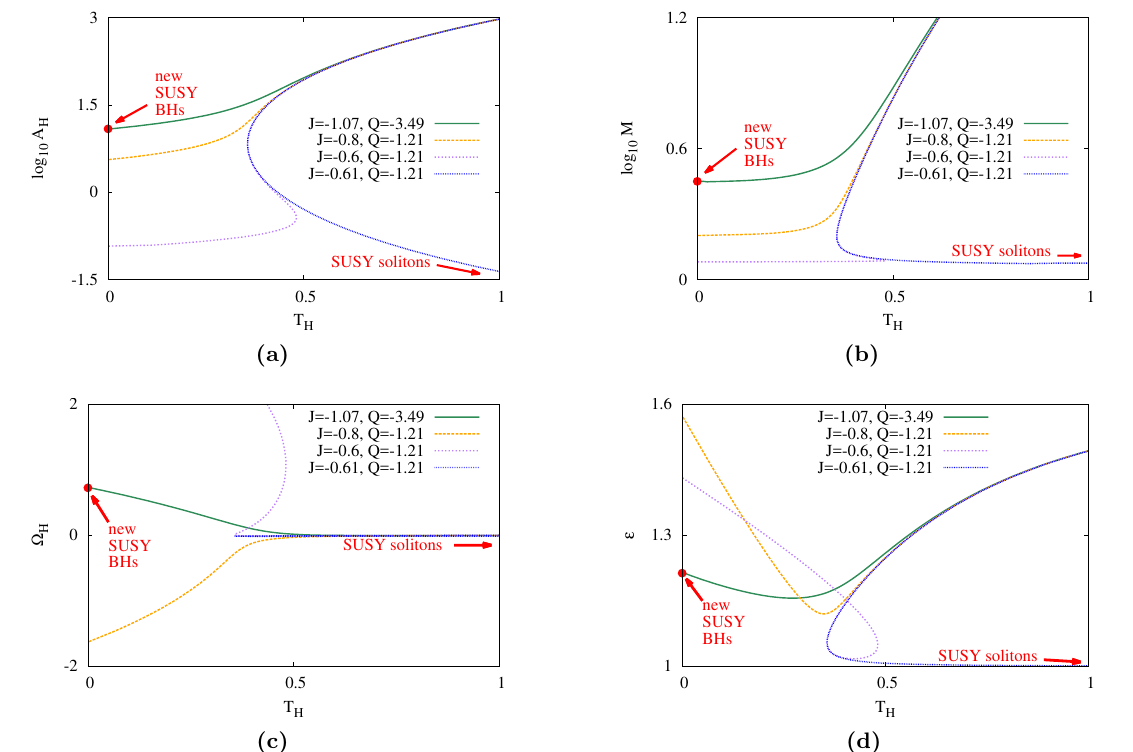
Figure 4. Several properties of squashed magnetized black holes are shown as a function of the horizon temperature. The con(cid:12)gurations have v = 1 : 65, c m = (cid:0) 1, L = 1 and di(cid:11)erent values of Q and J . The generic solutions possess an extremal (non-susy) limit (cyan, orange and purple lines). However, a particular set of solutions (red line in this (cid:12)gure) possess an extremal limit resulting in a supersymmetric black hole (red point). A di(cid:11)erent set of solutions (blue line) form a soliton in the limit of a vanishing horizon, T H ! 1 , which corresponds to the susy con(cid:12)guration in ref.